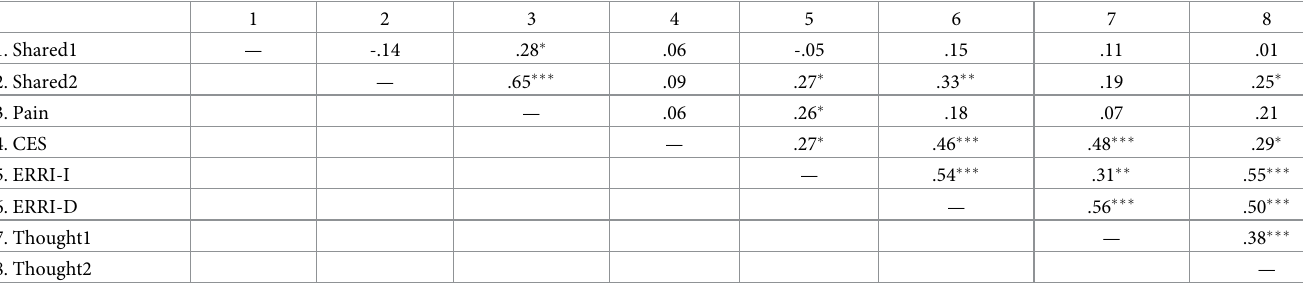
Table 3. Correlations among potential identity fusion mechanisms for postpartum